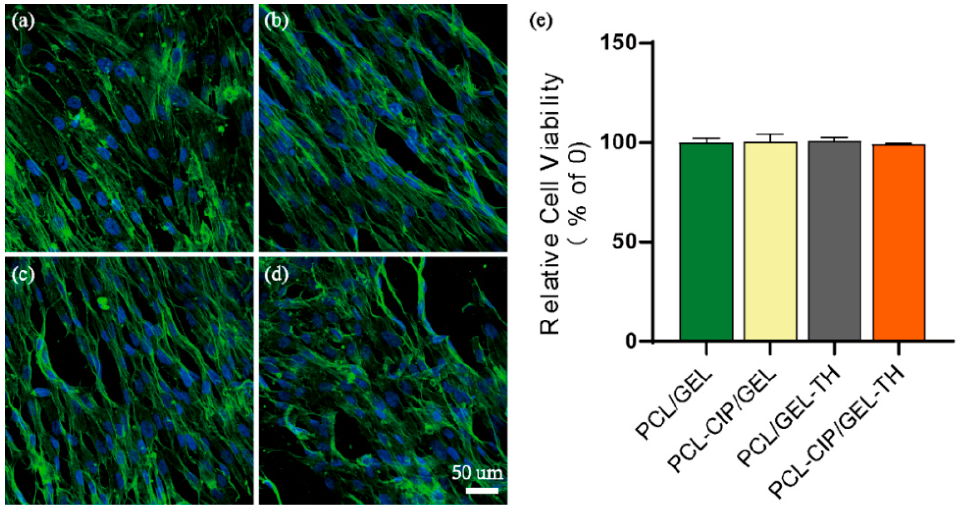
Figure 6. ( a – d ) The fluorescent images and ( e ) the viability of hSFCs cultured for 24 h on different samples.